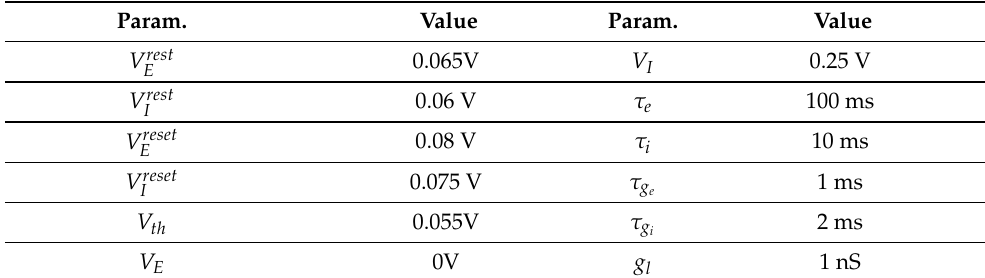
Table 2. Parameters in the proposed methodology. Param. Value Param. Value V rest E